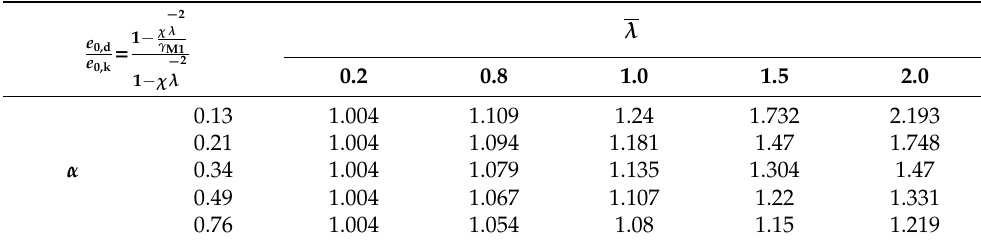
Table 2. Removing safety factor γ M1 from amplitude e 0,d decreases its value depending on imperfec- tion factor α and relative slenderness λ .